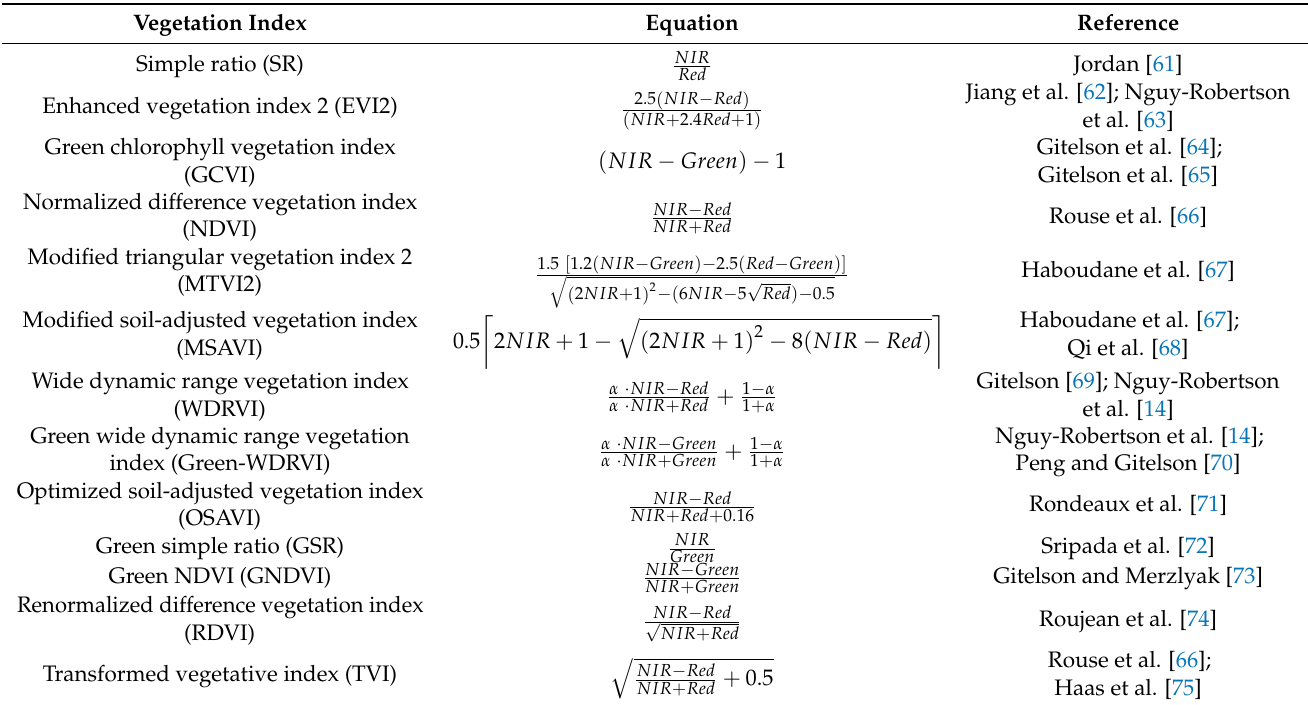
Table A1. Multispectral vegetation indices investigated in this